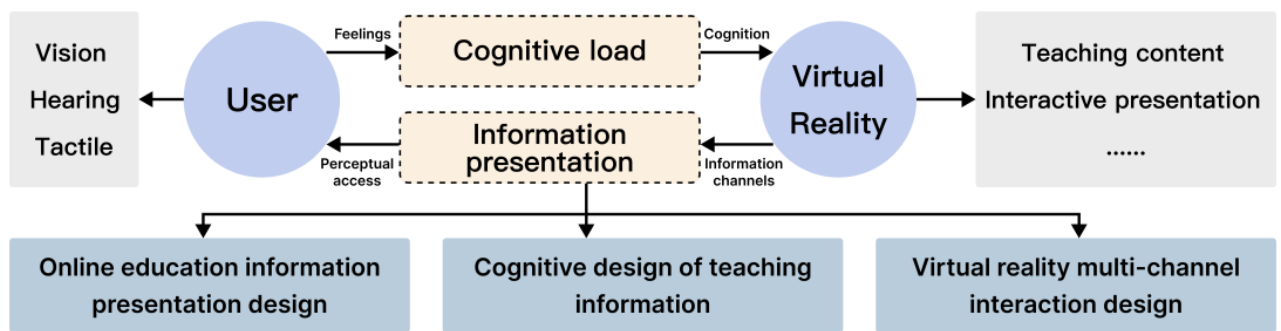
Figure 1. Theoretical research models related to virtual reality online education.